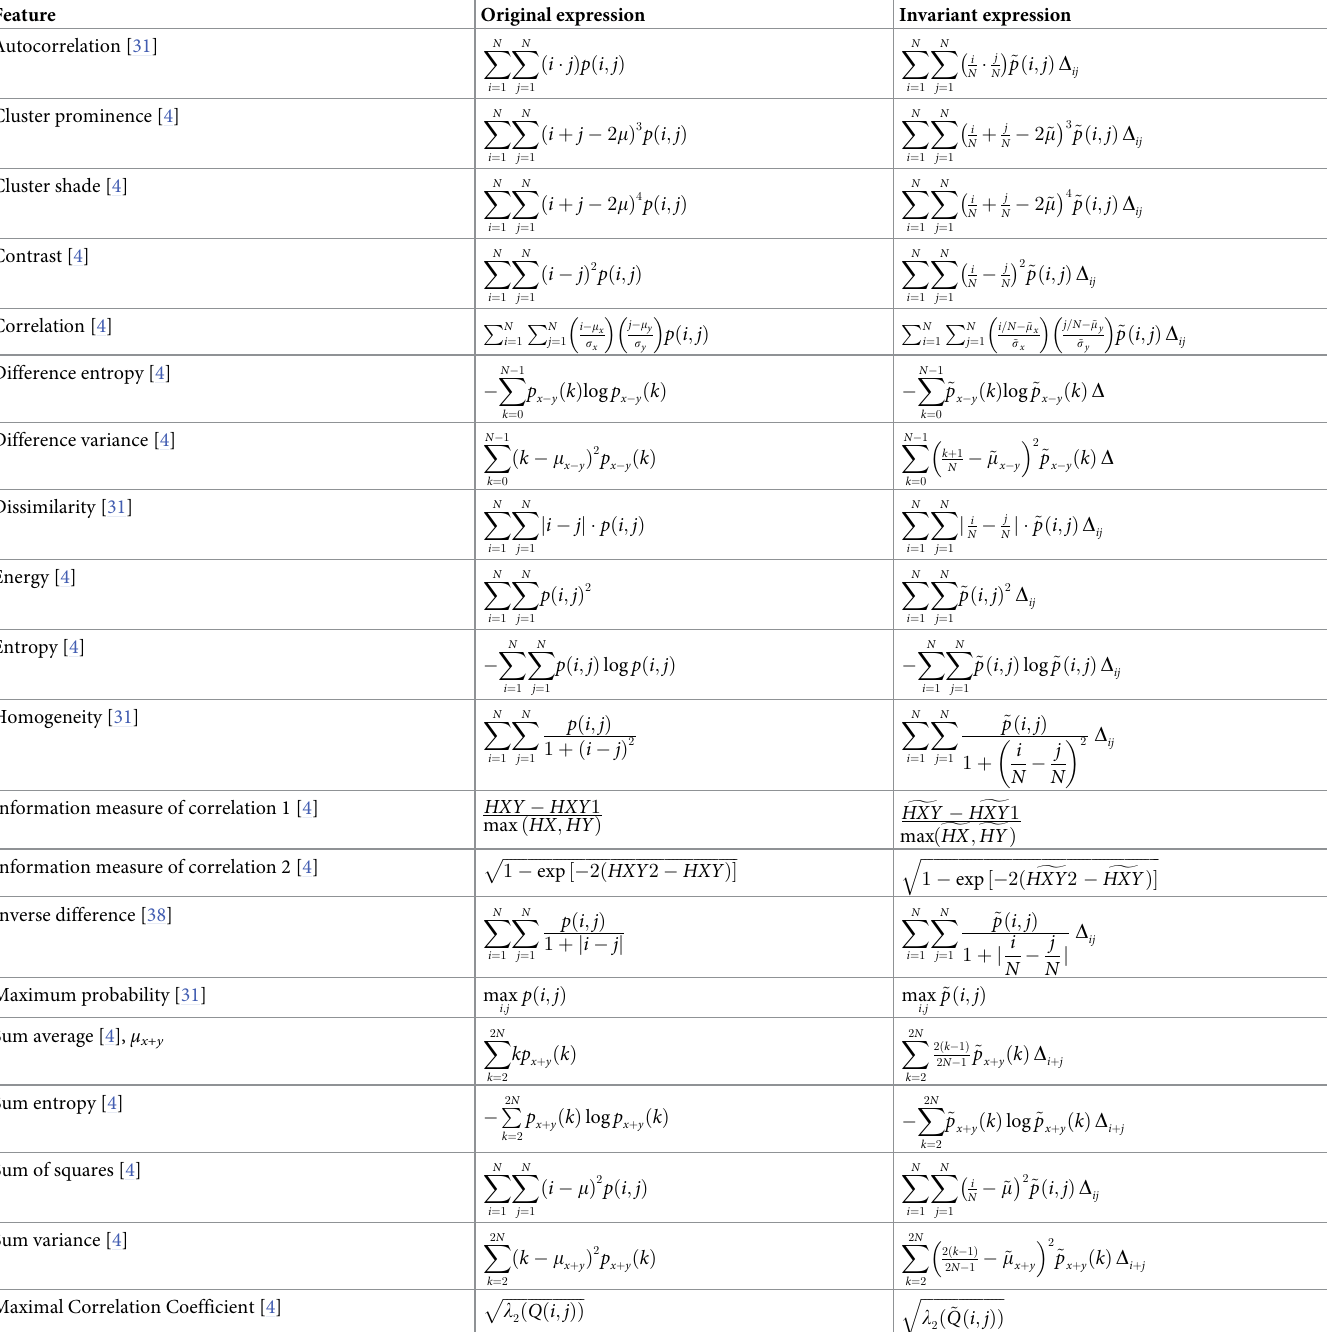
Table 2. The texture features computed from GLCMs. The middle column shows the original definitions, and the right column shows the modifications needed to make the features invariant to the number of gray-levels. There was an error in the definition of Sum variance in Haralick et al . [4], which has been corrected. λ 2 ( Q ( i , j )) denotes the second largest eigenvalue of a matrix Q ( i , j ). Note, however, that this feature is computationally unstable, and was therefore not included in the examples in this work. For symmetric GLCMs, μ x and μ y is identical, and is represented by μ in the expression for Cluster prominence and Cluster shade.